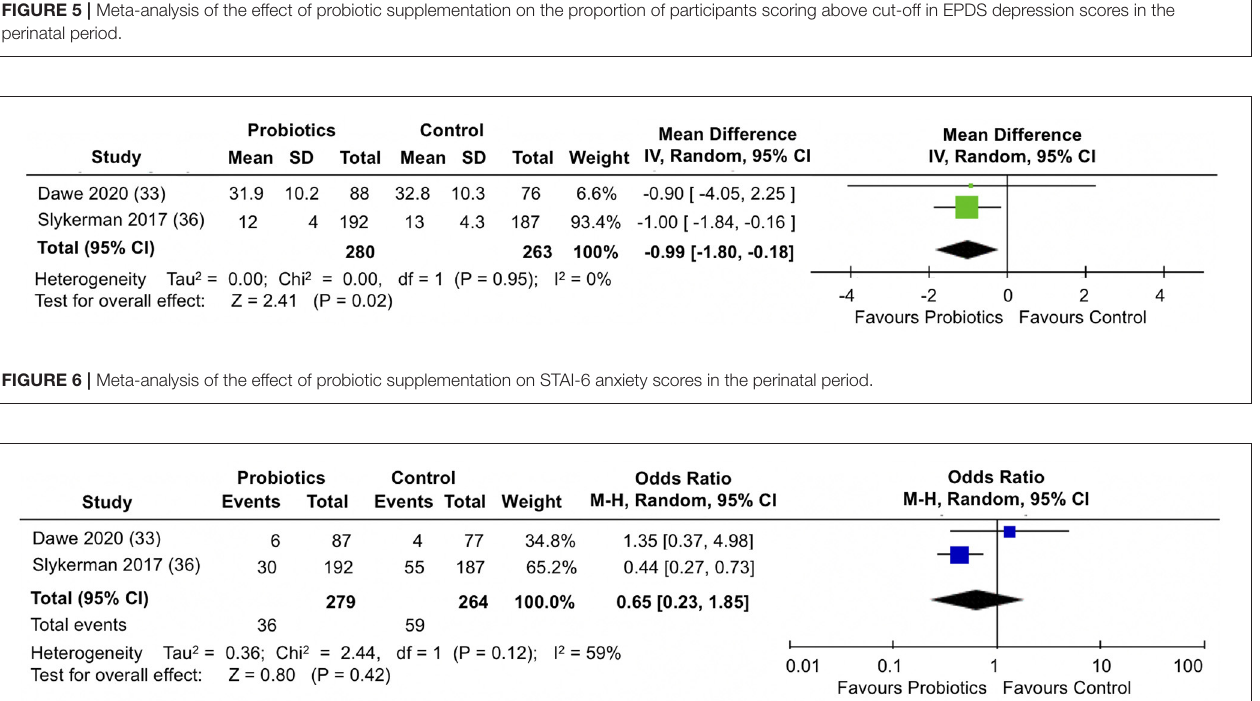
A meta-analysis of two trials (33, 34) involving a total of 224 participants ( Figure 8 ) did not show differences between the probiotic and control groups in the mean SF-36 mental